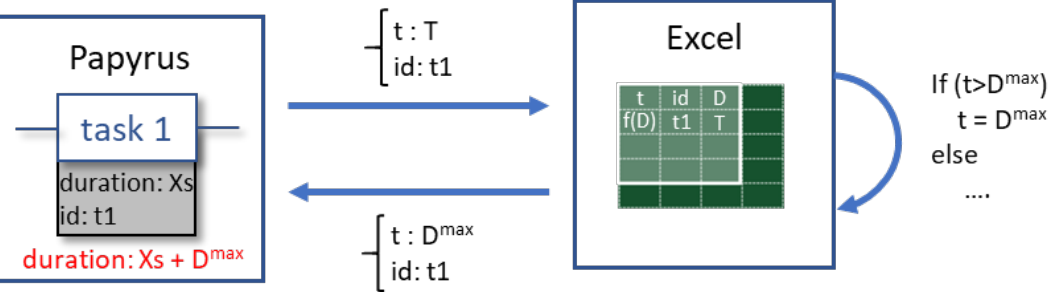
Figure 9. Dynamic risk management for Excel.